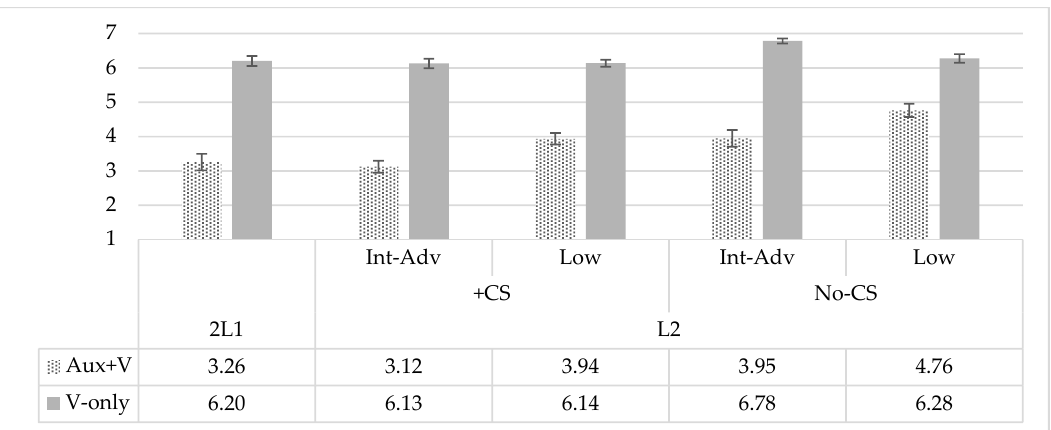
Figure 3. Code-switched verb stimuli ratings by group and type.